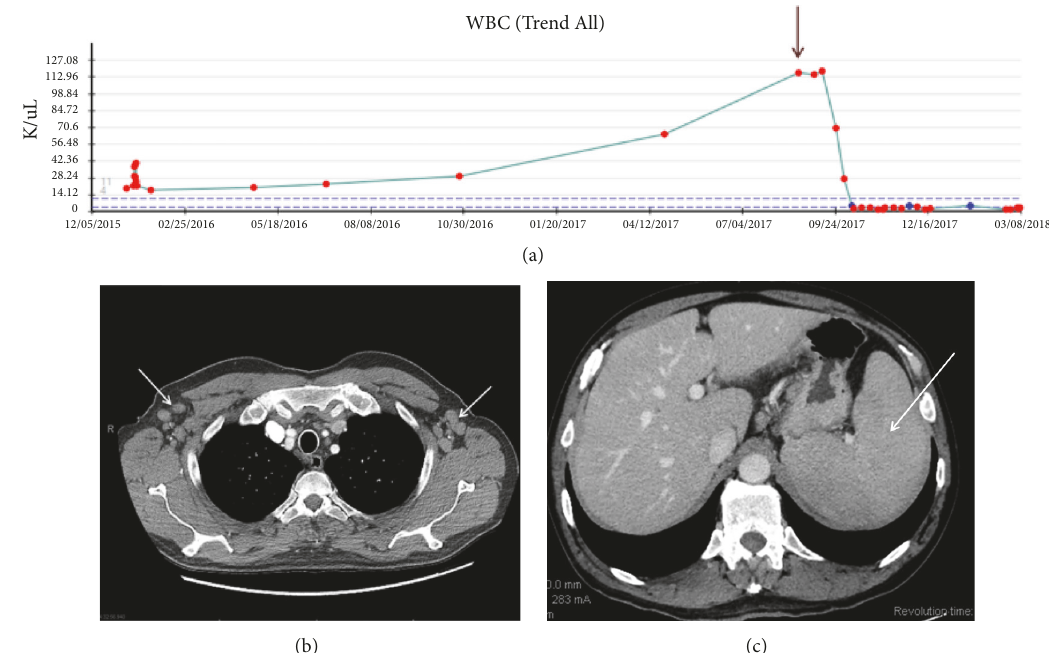
Figure 3: (a) Trending of WBC count from the time of diagnosis in January 2016 to the latest follow-up in March 2018. The arrow points to the WBC count at the time of bone marrow biopsy. It is noted that subsequent therapy led to leukopenia. (b) and (c) Computed tomography (CT) of mid-upper thorax shows multiple enlarged lymph nodes (arrows) in the mediastinum and axilla (b), while CT of the upper abdomen demonstrates a markedly enlarged spleen (arrow) (c).